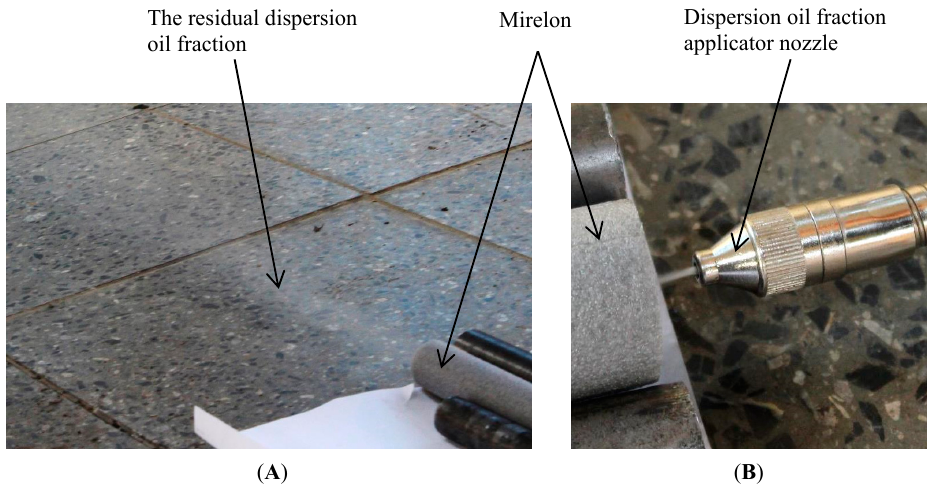
Figure 16. Details of how to apply the dispersion oil fraction to the inner surface of the tubes. ( A ) Photograph from experimental measurement shows the emerging fine oil mist; ( B ) The photograph shows the entry of a dispersion oil fraction into a pipe using a nozzle applicator.